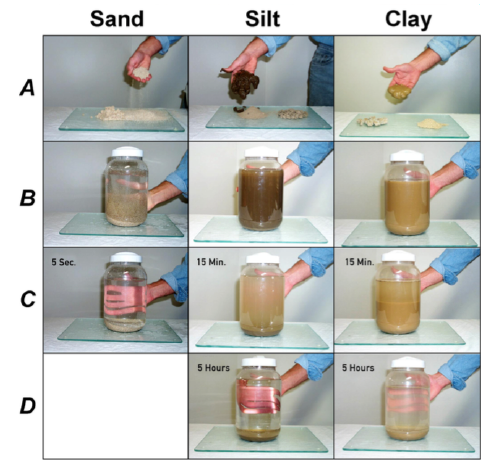
Figure 3 . (A) Sand, silt, and clay as dry sediments. (B) Sand, silt, and clay mixed in a column of clear fresh water. (C and D) Mixture of sand, silt, and clay after the designated settling time in stagnant water (Jablonski,